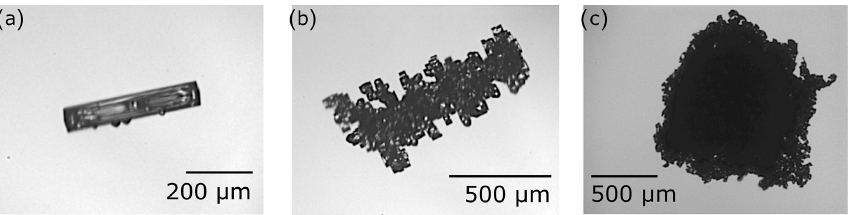
Figure 1. Example of a (a) slight “normally” rimed, (b) heavily “epitaxially” rimed column and (c) a graupel particle captured by the PHIPS probe during the IMPACTS